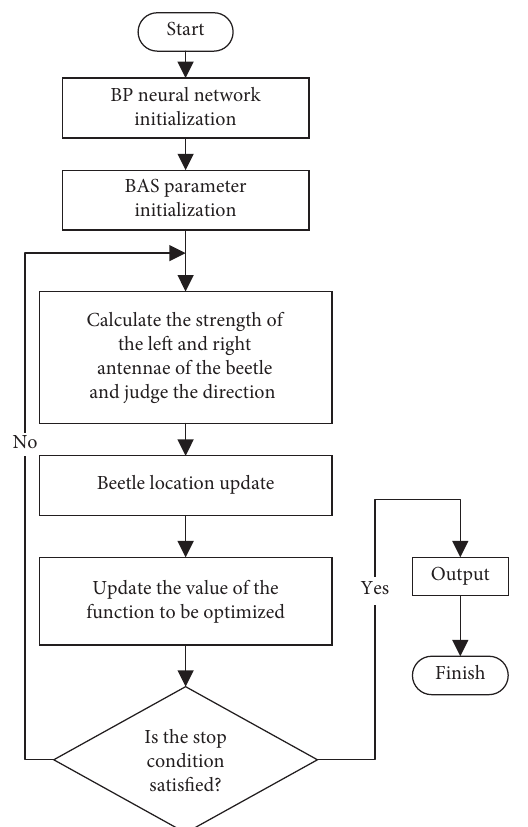
Figure 3: Te framework of the BAS in BP network.